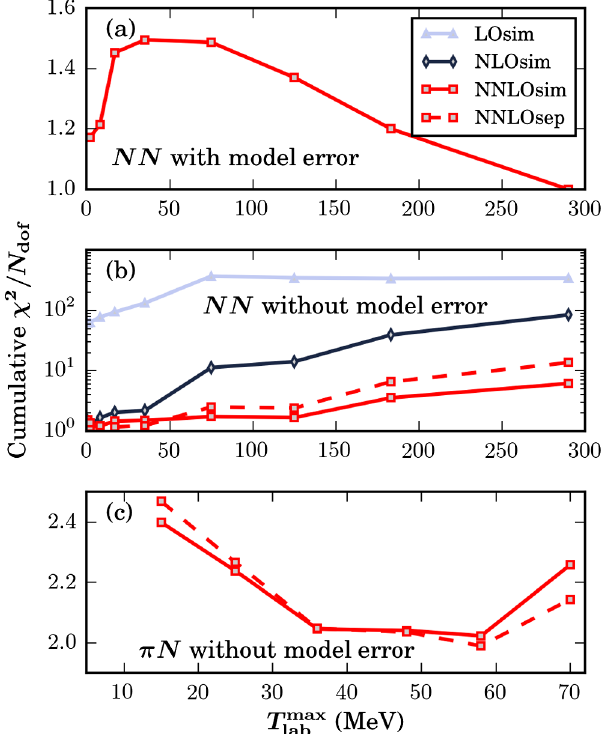
FIG. 5. (a) Cumulative χ 2 =N for NN scattering data includ- dof ing the model error (see Sec. II E). Note that the amplitude of the 1 when all data up to model error is chosen so that χ 2 =N dof ¼ 290 MeV are included. (b,c) Cumulative χ 2 =N T without lab ¼ dof the model error for NN and π N scattering data, respectively.